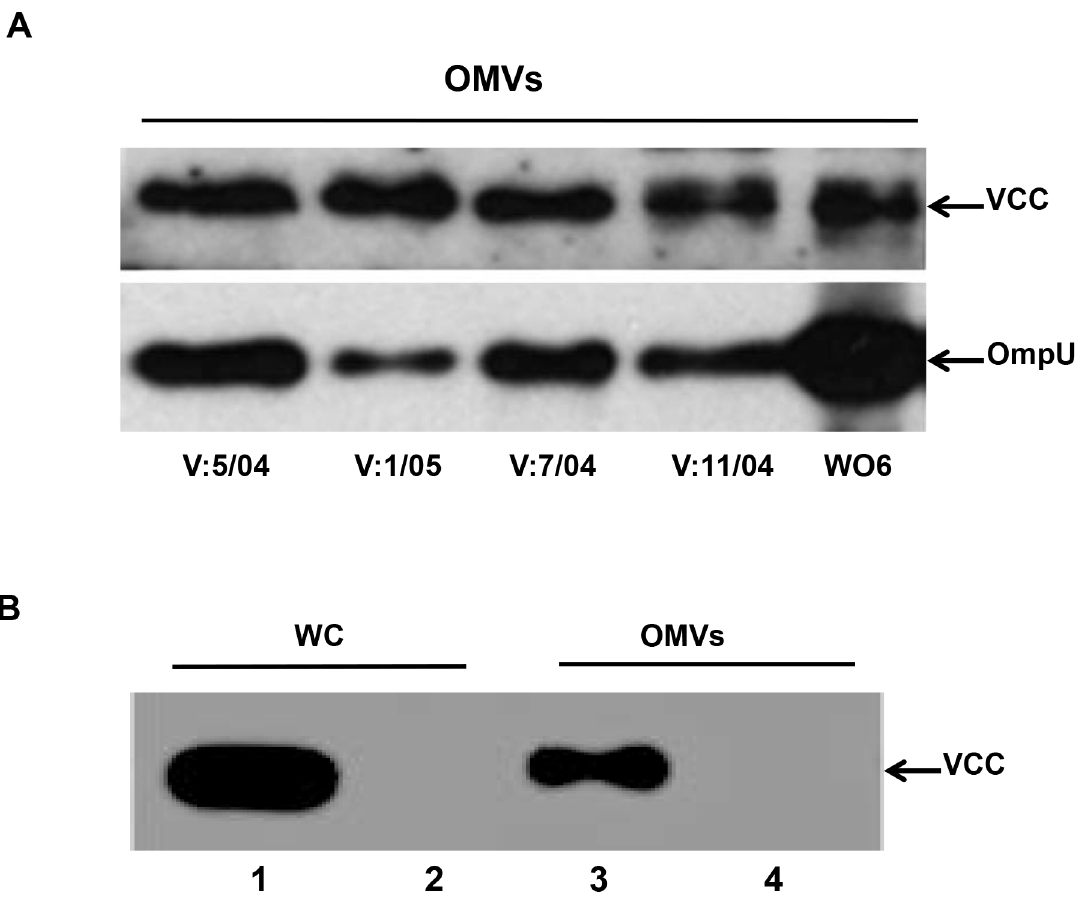
Figure 8. OMV-mediated transport of VCC is a common phenomenon. (A) Immunoblot analysis of OMVs from V. cholerae strains V:5/04, V:1/ 05, V:7/04,V:11/04 and WO6. (B) Immunoblot analysis of whole cell lysate (WC) and OMVs of E. coli strains MC1061/pBAB2 (1, 3) and MC1061/pBR322 (2, 4), respectively.